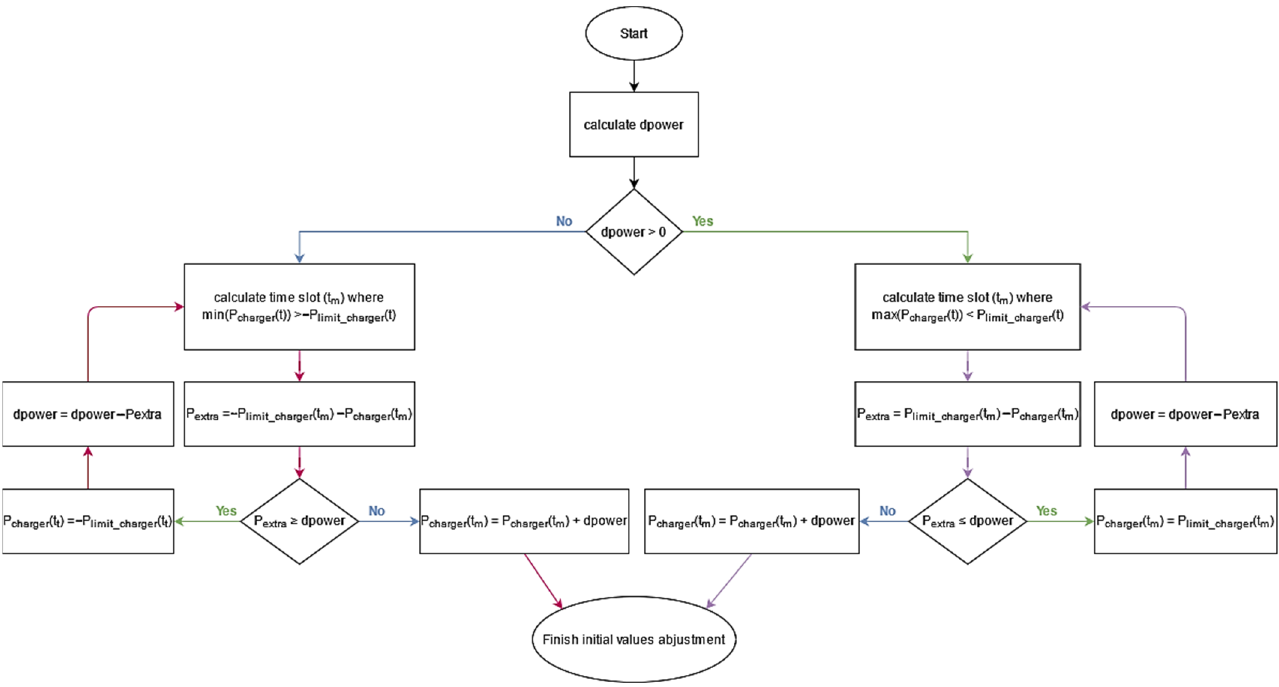
Figure 6. PSO initialization process.